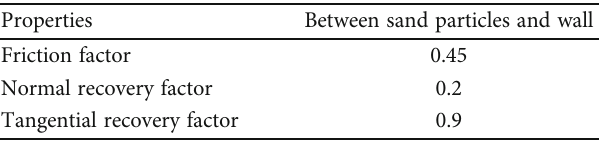
Table 2: Interaction parameters between the sand particles and the wall.